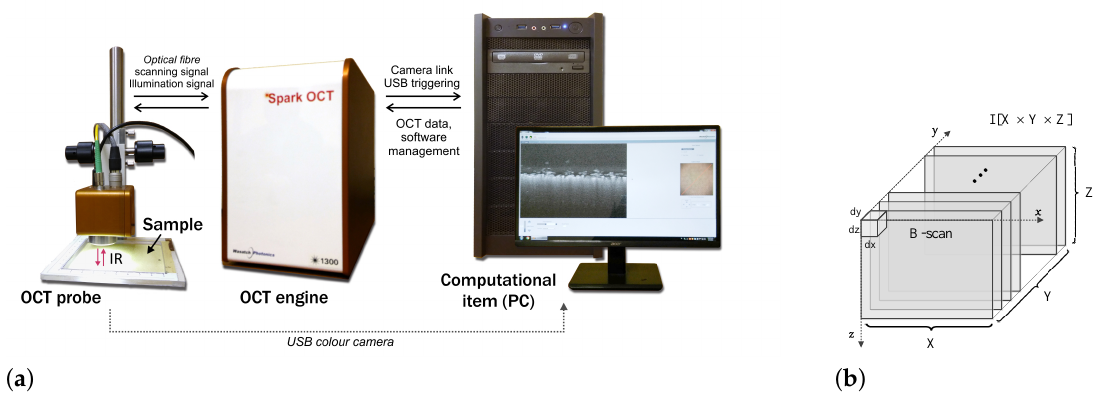
Figure 2. Acquiring images of textile fabric ( a ) The functional modules of Spark OCT 1300 nm system; ( b ) the stack of acquired B-scans equivalent to volumetric